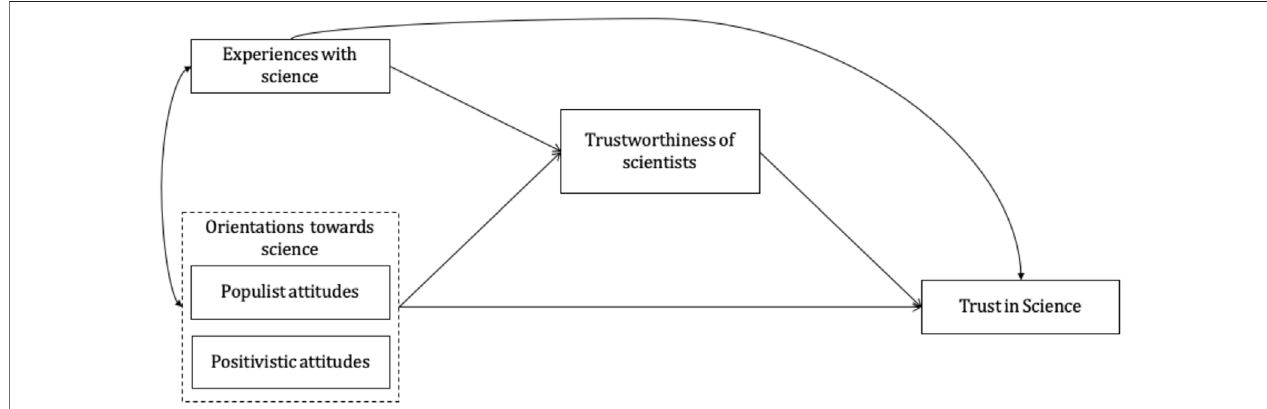
FIGURE 1 | Theoretical model of trust in